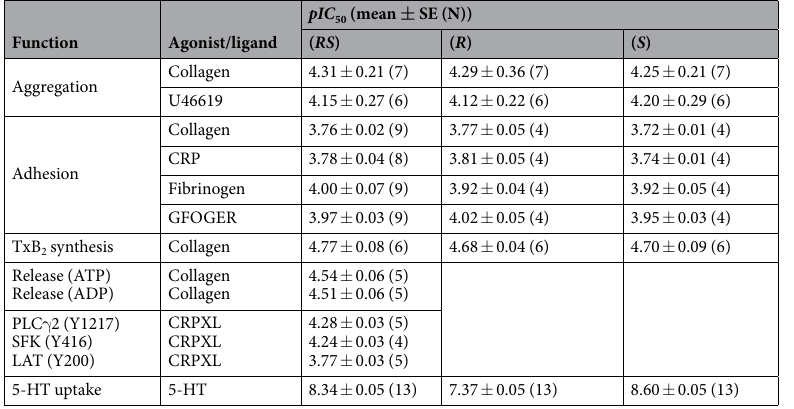
Table 1. Summary pIC 50 values (mean ± SE (N)) for ( RS )-, ( R )- and ( S )-citalopram on platelet aggregation, static adhesion to collagen, TxB